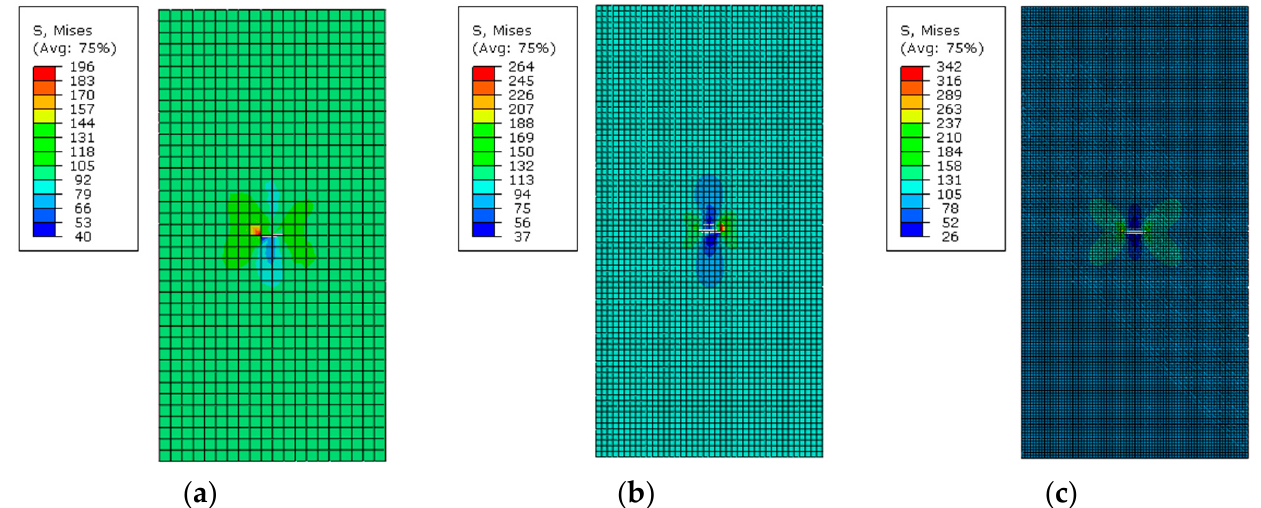
Figure 4. The stress contour plot of σ yy for the central cracked plate in different element; ( a ) h = 10 mm; ( b ) h = 5 mm; ( c ) h = 2.8 mm. Table 1. Normalized SIFs in the central cracked plate.